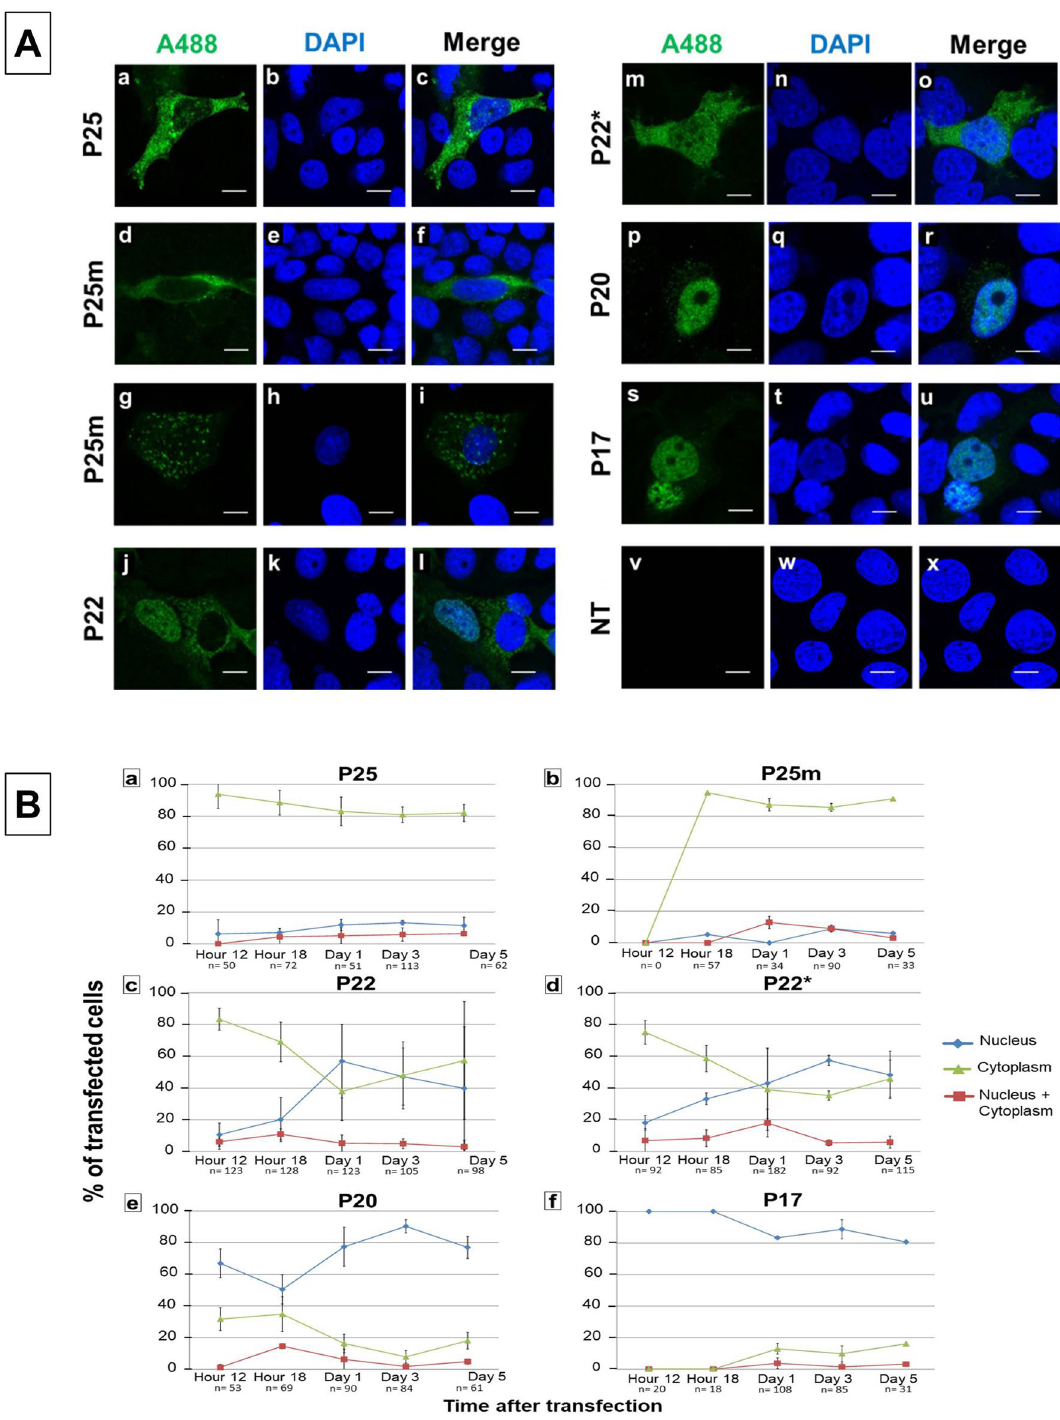
Figure 2. Localization of HBeAg and its precursors over time. ( A ) Intracellular localization of P25, P25m (P25 G1862T), P22, P22*, P20 and P17 proteins from subgenotype A1, after transfection of pcDNA_A1P25 (a–c), pcDNA_A1P25m (d–i), pcDNA_A1P22 (j–l), pcDNA_A1P22* (m–o), pcDNA_A1P20 (p–r), pcDNA_A1P17 (s-u). (*) means the core protein is knocked out. HBV proteins were expressed in HuH-7 cells under the control of the CMV promoter. Cells were immunostained with a polyclonal rabbit anti-HBc antibody (DAKO, (a,d,g,j,m,p,s,v)) and viewed with a confocal microscope at day 3 post-transfection. Nuclei were visualized by DAPI staining (b,e,h,k,n,q,t,w); merge (c,f,i,l,o,r,u,x). NT non-transfected cells. ( B ) Determination of concentration of HBeAg and precursors depicted as quantitative results of 2 to 4 experiments at 12 h, 18 h, day 1, day 3 and day 5 post-transfection. The lines show the predominant localization of HBeAg and its precursors. Accumulation in nucleus or cytoplasm shown in blue or green, respectively. Red lines show an equal distribution between the nucleus and the cytoplasm. The numbers (n) below each graph indicate the number of transfected cells